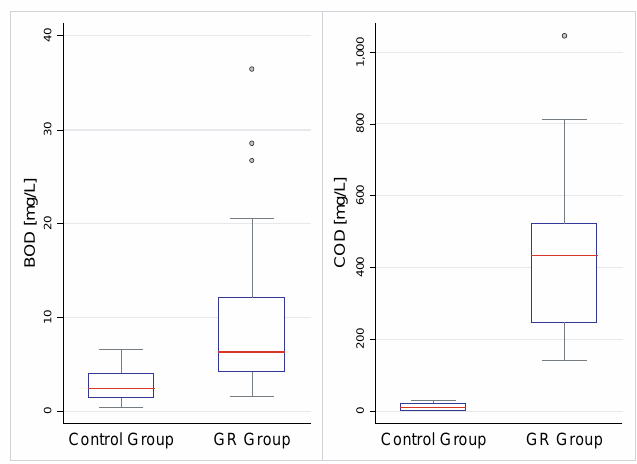
Figure 8. Effect of green roofs on organic matter parameters. BOD: biological oxygen demand; COD: chemical oxygen demand.